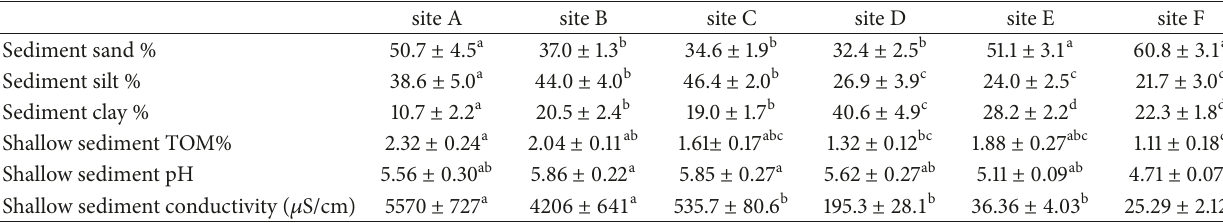
Table 2: Spatial variation of sediment quality parameters in sampling sites during the study period. Data are presented as mean ± standard deviation (SD). Results indicated by different superscript letters in each row are significantly different from each other (ANOVA, Tukey’s test, p < 0.05, n=10).